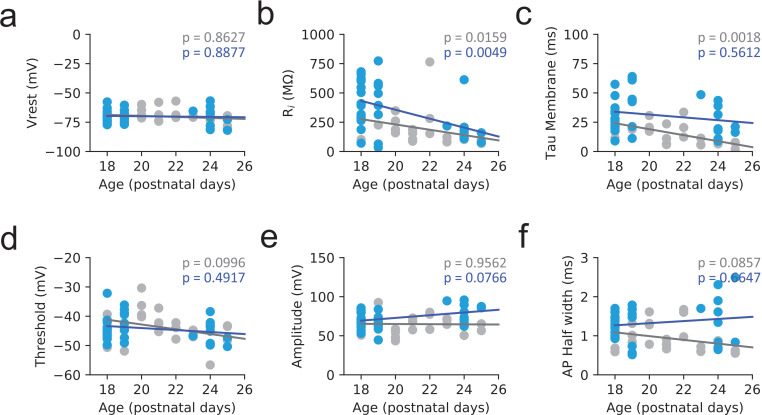
PV cells passive and active properties as function of Age.Passive properties plotted as a function of age during the developmental period under study. (a) Resting membrane potential (Vrest). (b) Input Resistance (Ri). (c) Membrane time constant (Tau membrane). (d) Action potential threshold. (e) Action potential amplitude. (f) Action potential half width (n = 28 and 26 cells for Eu and Ts, respectively). In all panels continuous lines represent the linear fit to each data set (Eu: gray, Ts: blue). Spearman correlation test p value is indicated in all panels for Eu (gray) and Ts (blue).